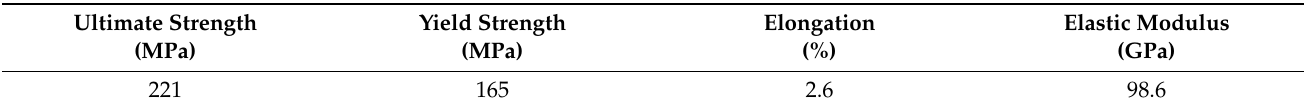
Table 2. Mechanical properties of F3S.10S composite.